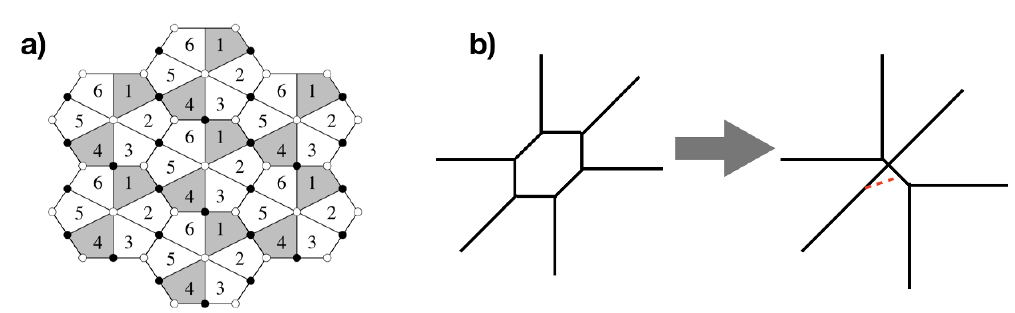
Figure 3 . (a) Dimer diagram showing a deformation fractional brane in the dP 3 theory; (b) Web diagram, and its splitting into subwebs in equilibrium, with the (cid:12)nite size S 3 displayed as a red discontinuous segment suspended between the